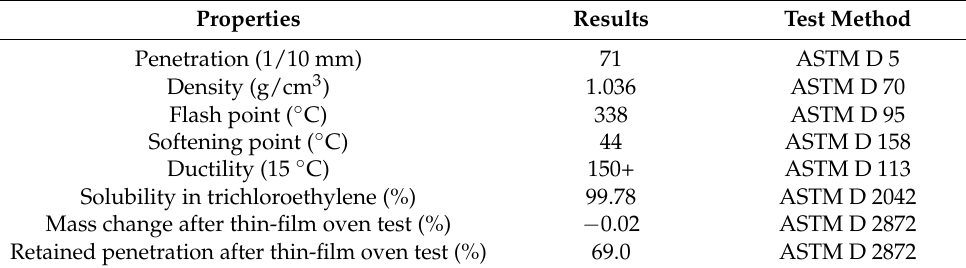
Table 4. Specifications of the asphalt binder.